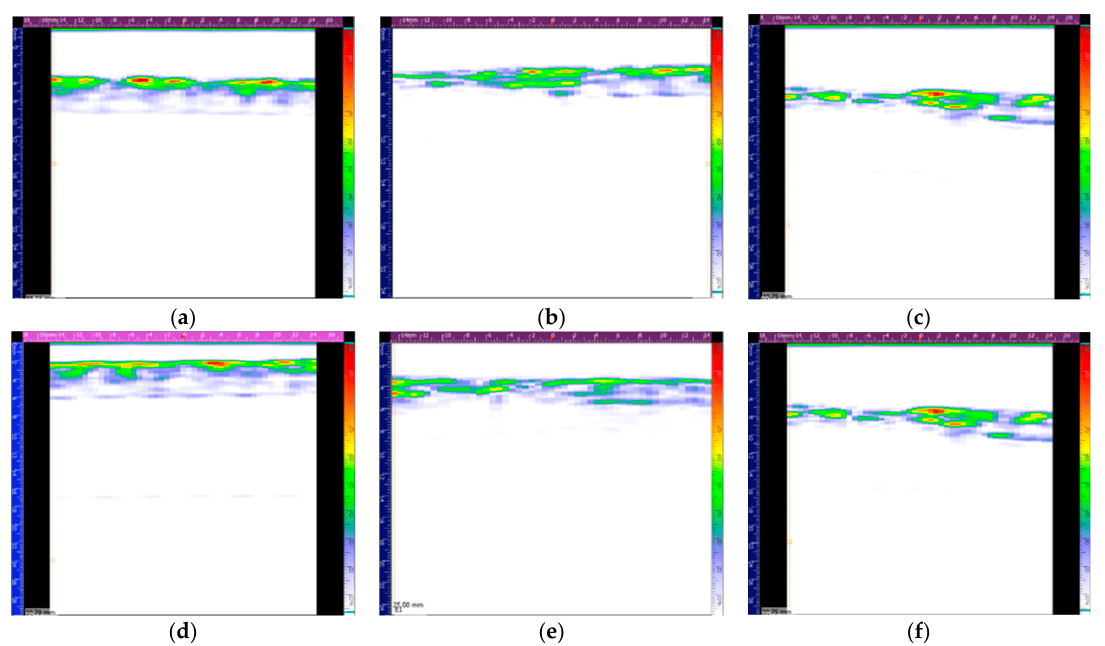
Figure 12. Phased array ultrasonic observations of specimens with an LDOF 001 (top) and 002 (bottom) with a single FBG S+T in location T0: ( a , d ) before impact, ( b , e ) after the first impact, and ( c , f ) after the second impact.